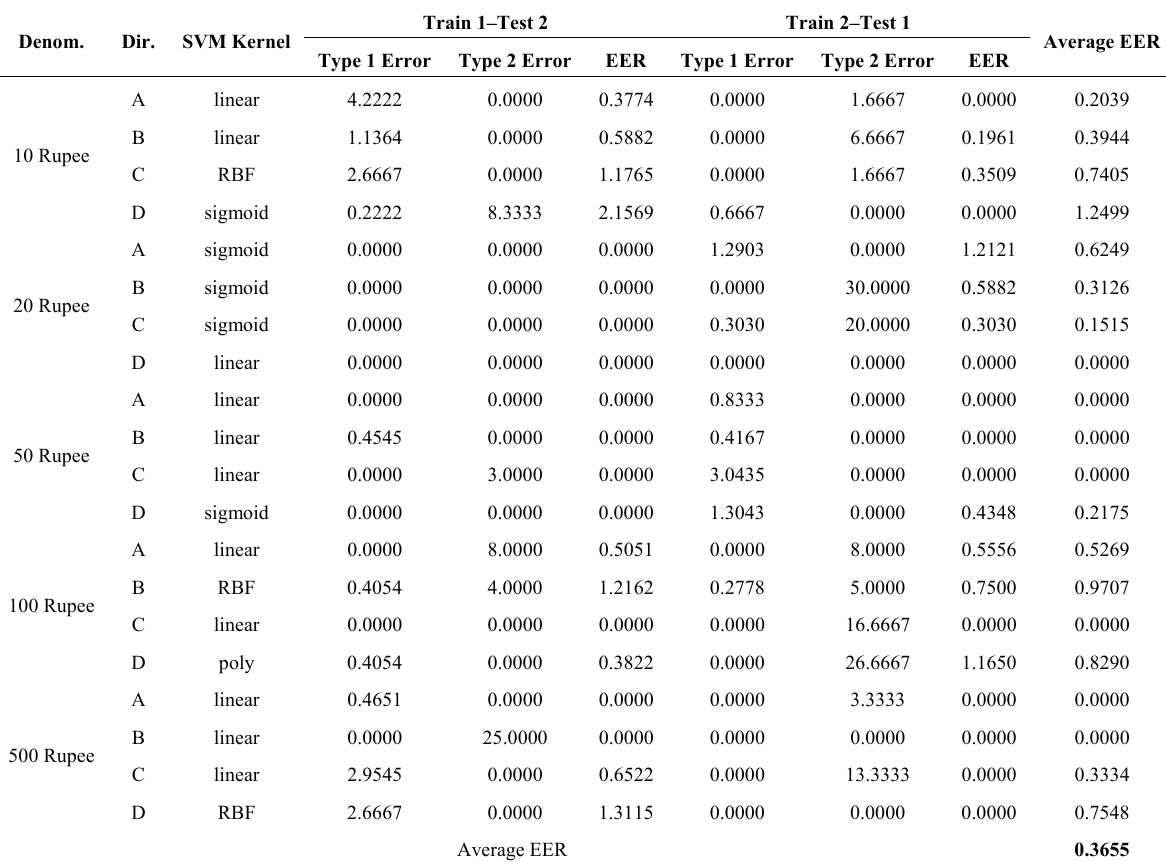
Table 5. Experimental results with testing data by Daubechies DWT and SVM classification. ( Denom . and Dir . are denominations and directions, respectively. Poly indicates a polynomial kernel.) (unit: %).